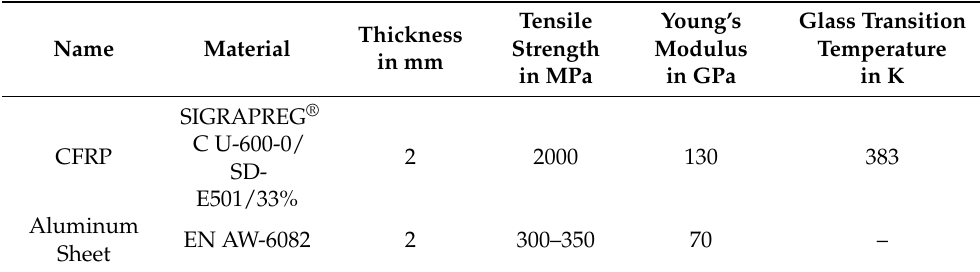
Table 1. Properties of utilized materials [25,26].